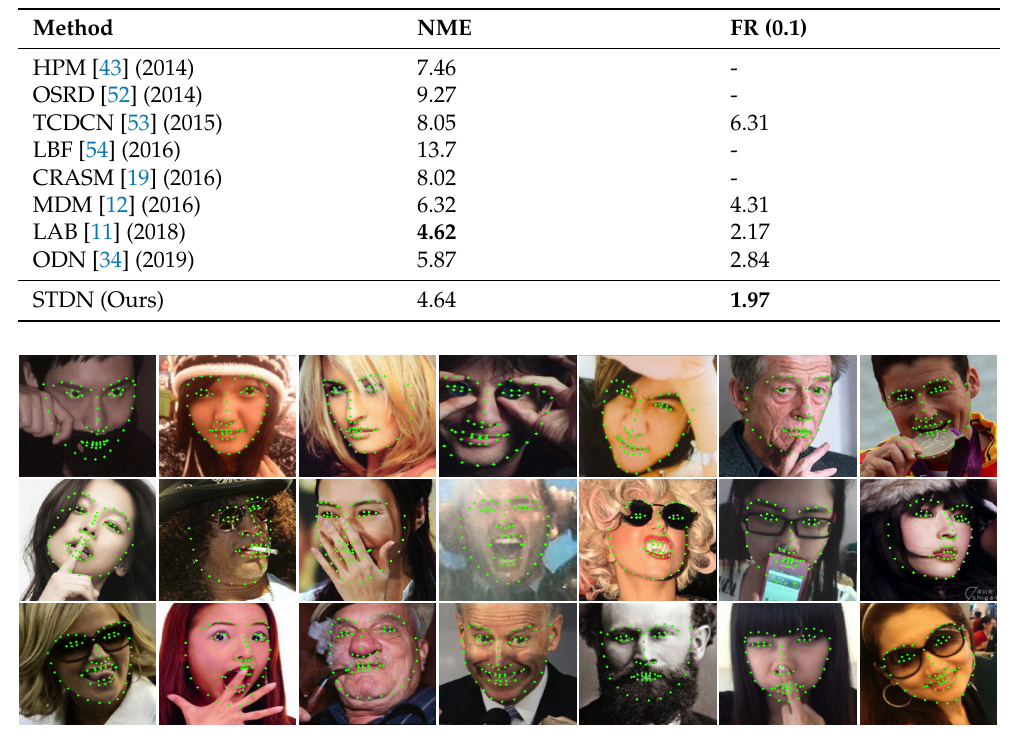
Figure 8. Representative results on COFW68.